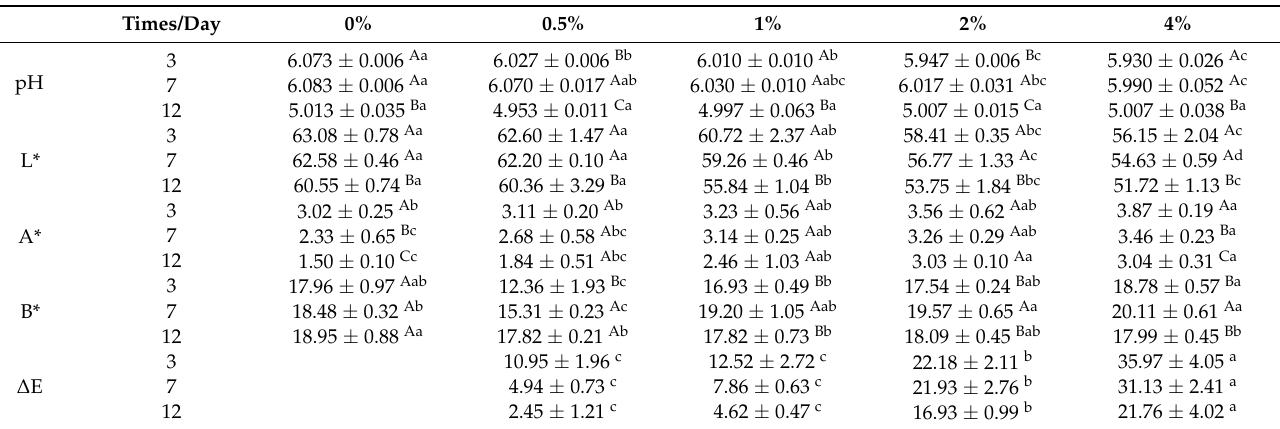
Table 1. Effects of LNT content and storage time on pH and color changes in goose meatballs during cold storage (4 ◦